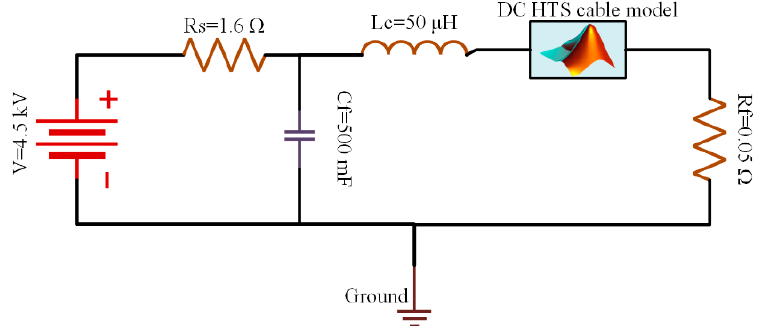
Figure 4. The test grid used for characterizing the understudied DC HTS cables.